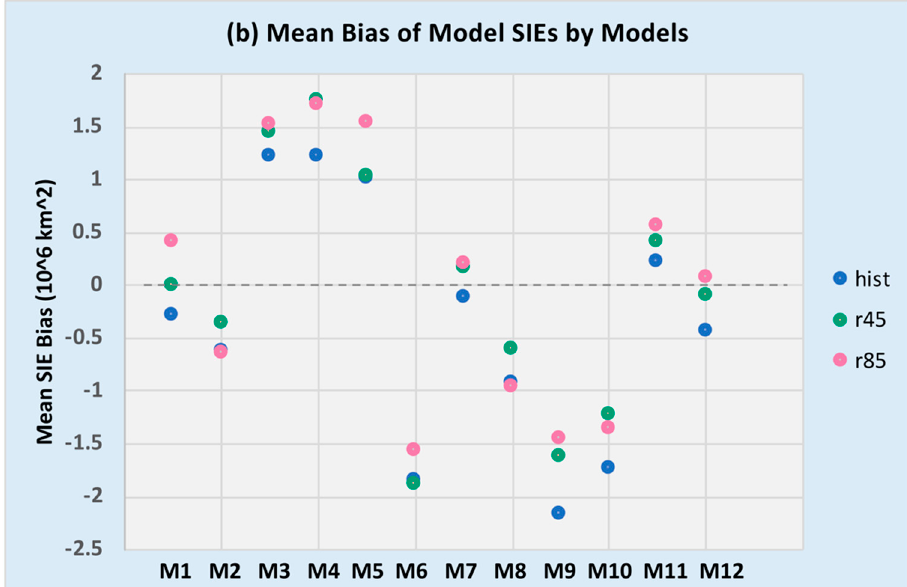
Figure 6. The mean bias of the model SIEs from the observed SIEs as a function of ( a ) types of runs and ( b ) models. The record period for the historical simulations (hist) was from January 1979 to December 2005. The record period for the projections (r45 and r85) was from January 2006 to December 2017. See Tables 2–4 for the numerical values of the mean bias and Table 1 for climate models associated with the model ID in ( b ).